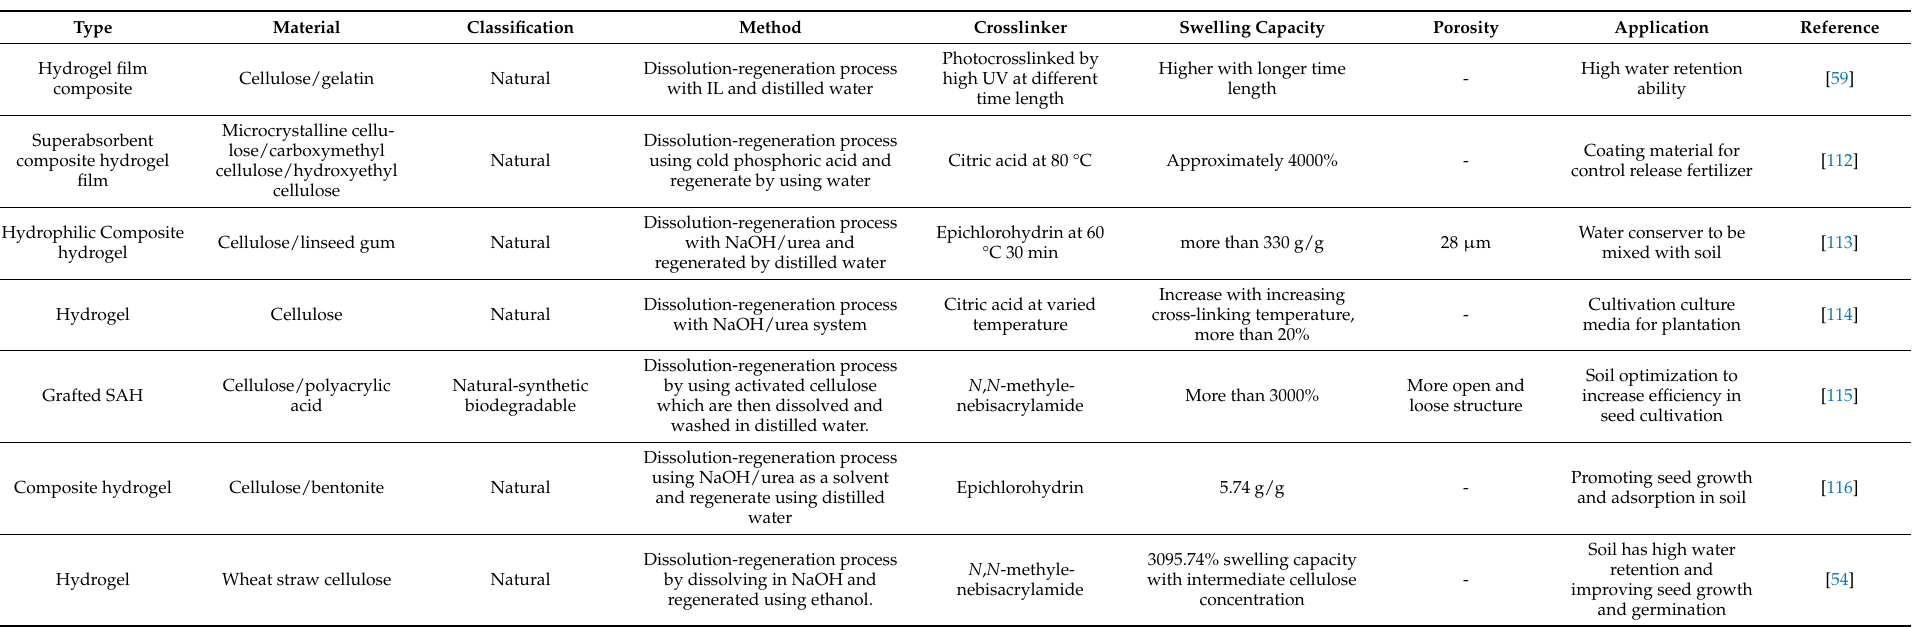
Table 5. Example of the RC products in the agricultural potential